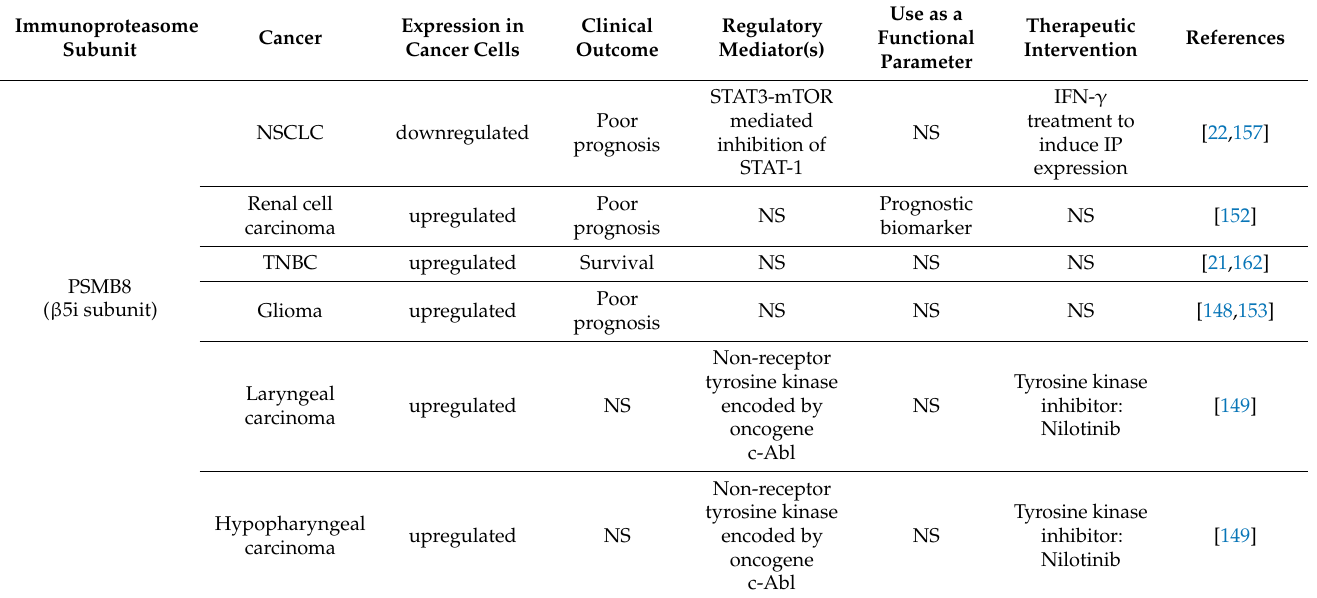
Table 1. Immunoproteasomal subunit in different cancers: Expression, Function, and Intervention. Immunoproteasome